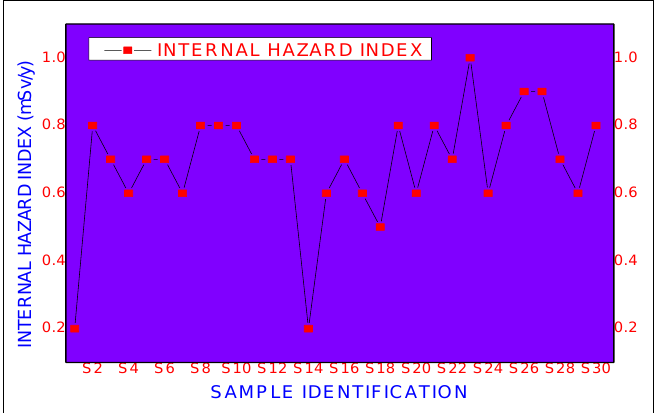
Figure 4: Internal Hazard Index for the Collected